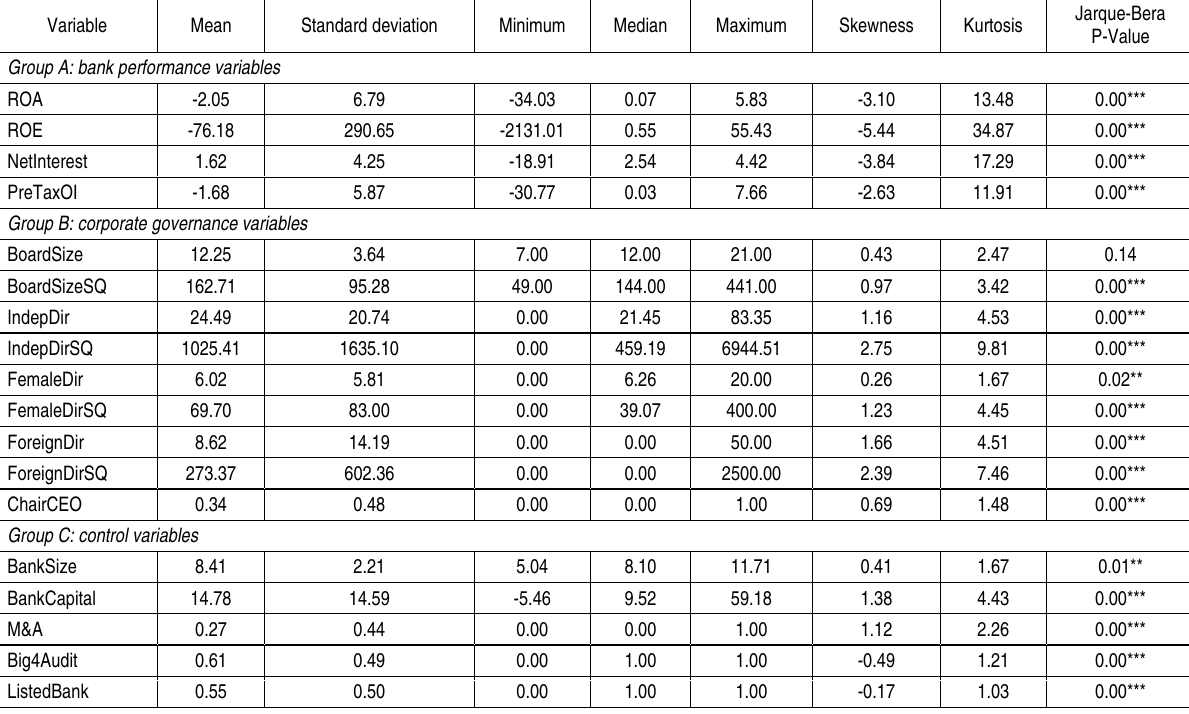
Table 1. Full sample descriptive